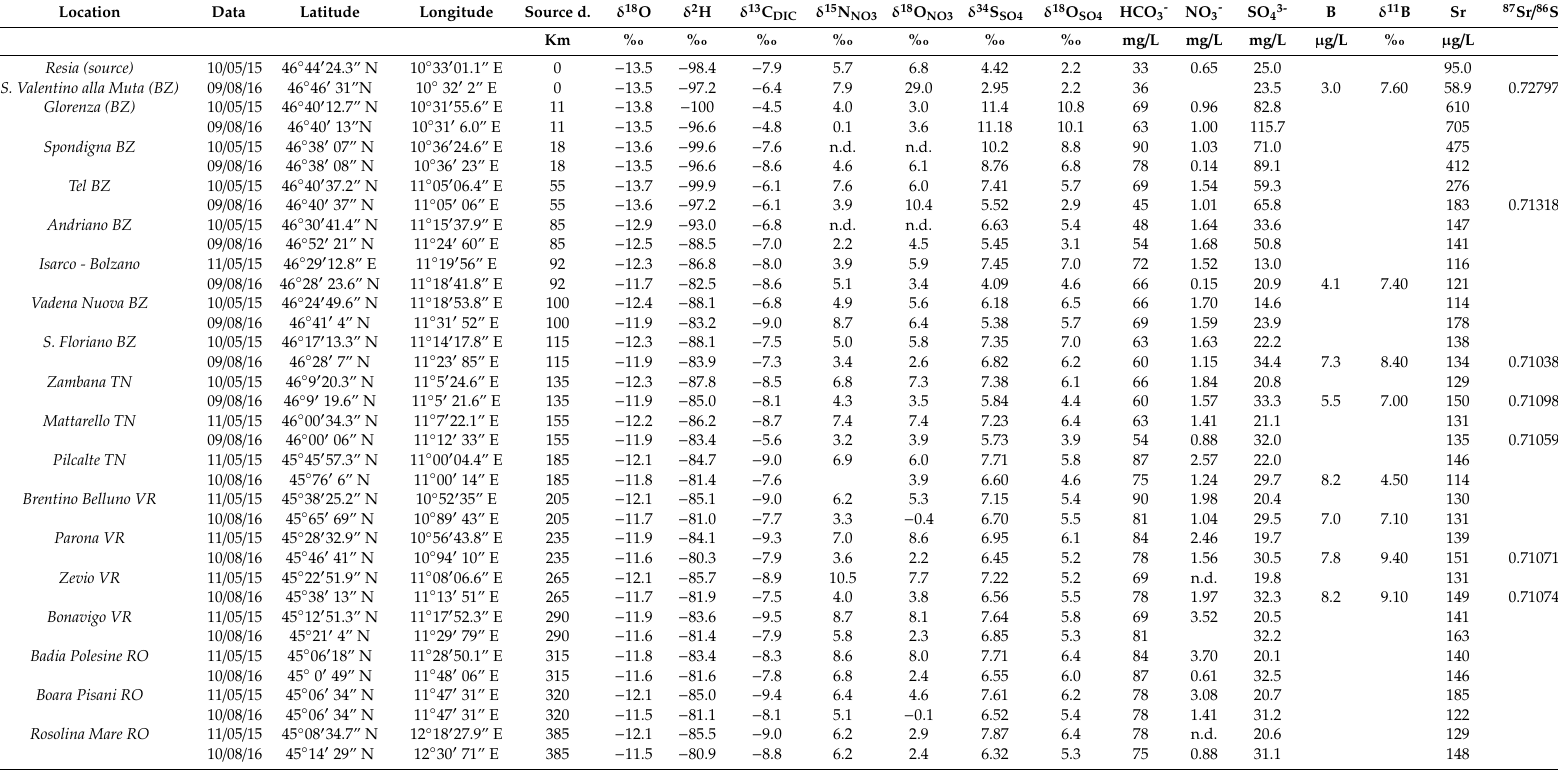
Table 1. Adige river sampling sites, elemental and isotopic composition of the river water collected in May 2015 and August 2016. n.d. = not detected.